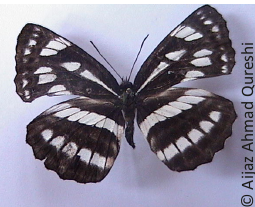
Image 21. Pontia daplidice during mating